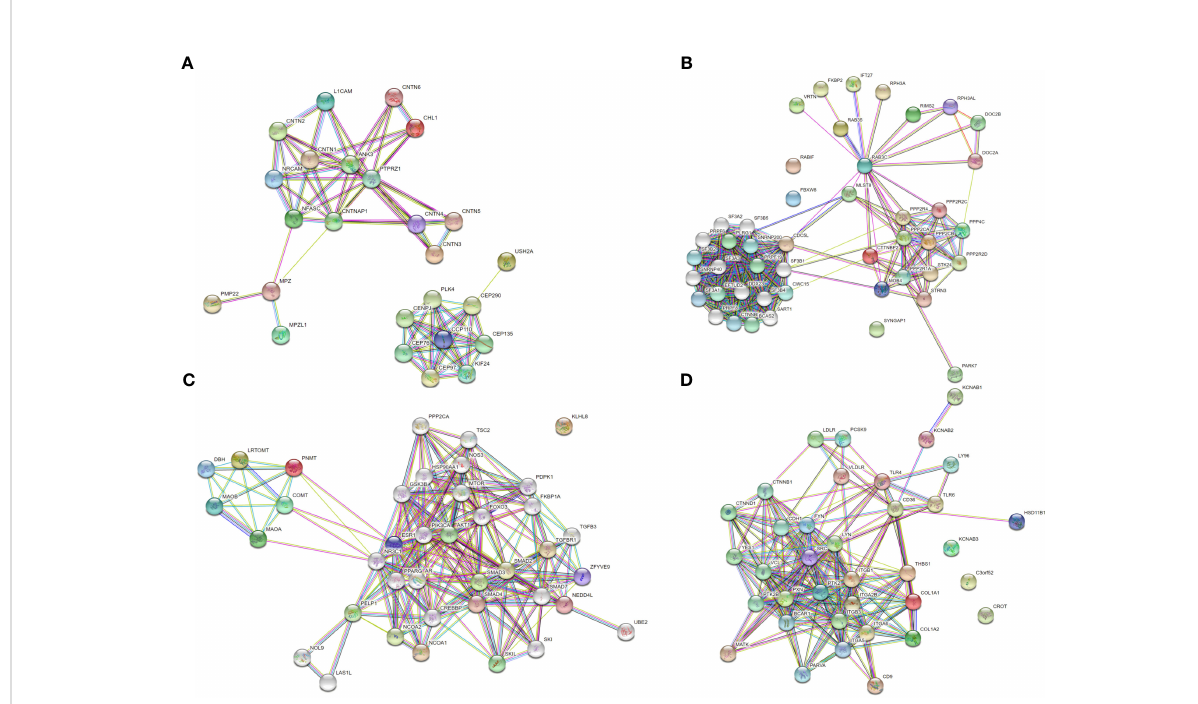
FIGURE 6 Protein-protein interaction (PPI) network based on differentially expressed proteins. Each node indicates an individual protein, red nodes indicate upregulated proteins in AMH tissue, and green nodes indicate downregulated proteins in AMH tissue. (A) PPI network based on upregulated MPZ.P0. (B) PPI network based on upregulated RAB3C. (C) PPI network based on upregulated PNMT. (D) PPI network based on downregulated CD36.